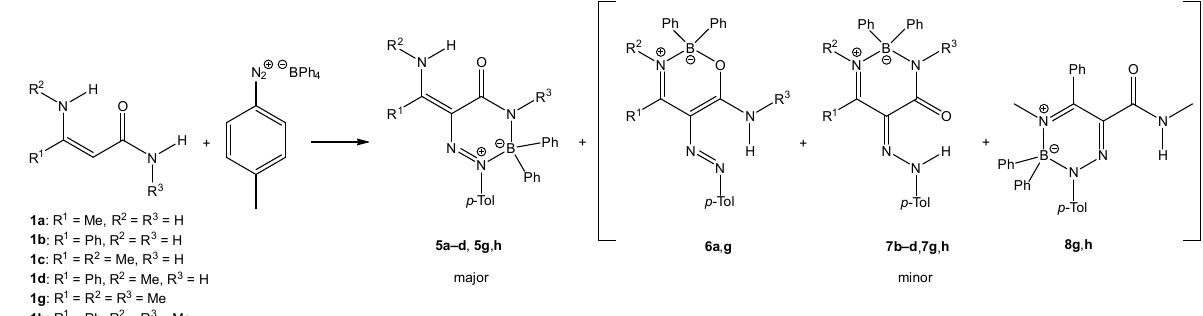
Scheme 3. The reaction of enaminoamides 1a – d , 1g , and 1h .